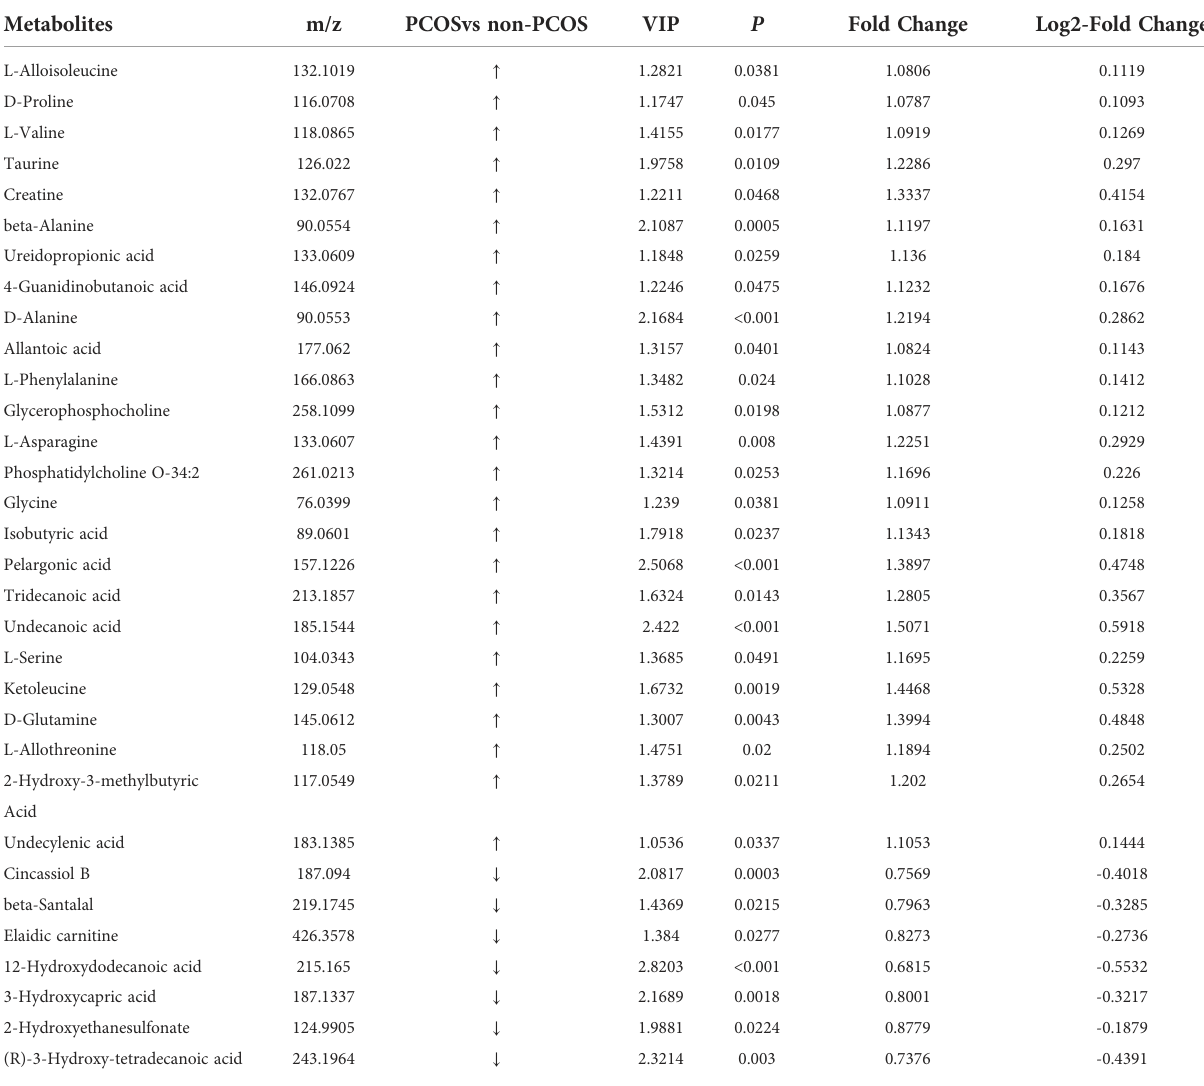
TABLE 2 Characteristics of the differential metabolites of women with PCOS in embryo culture fl